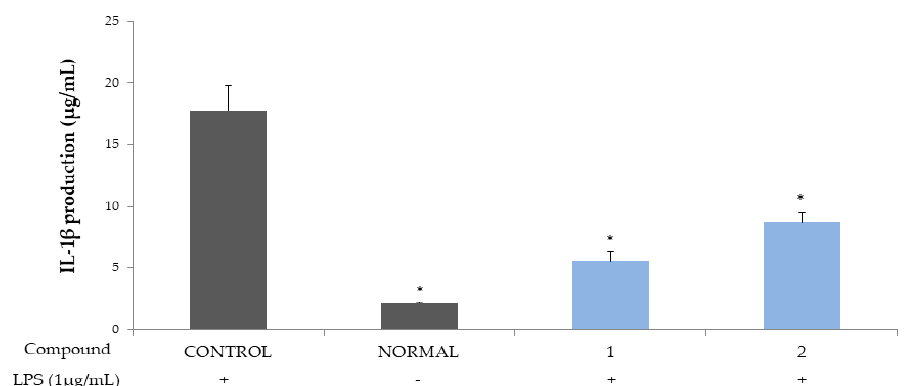
Figure 4. Inhibitory activities of compounds 1 and 2 on IL-1β production in the THP-1 macrophage cell. Control, compounds 1 and 2 were added LPS (1 μg/mL). Normal was not added LPS. Values are expressed as the mean ± standard deviations (SDs) from triplicate measurements. * p < 0.05.